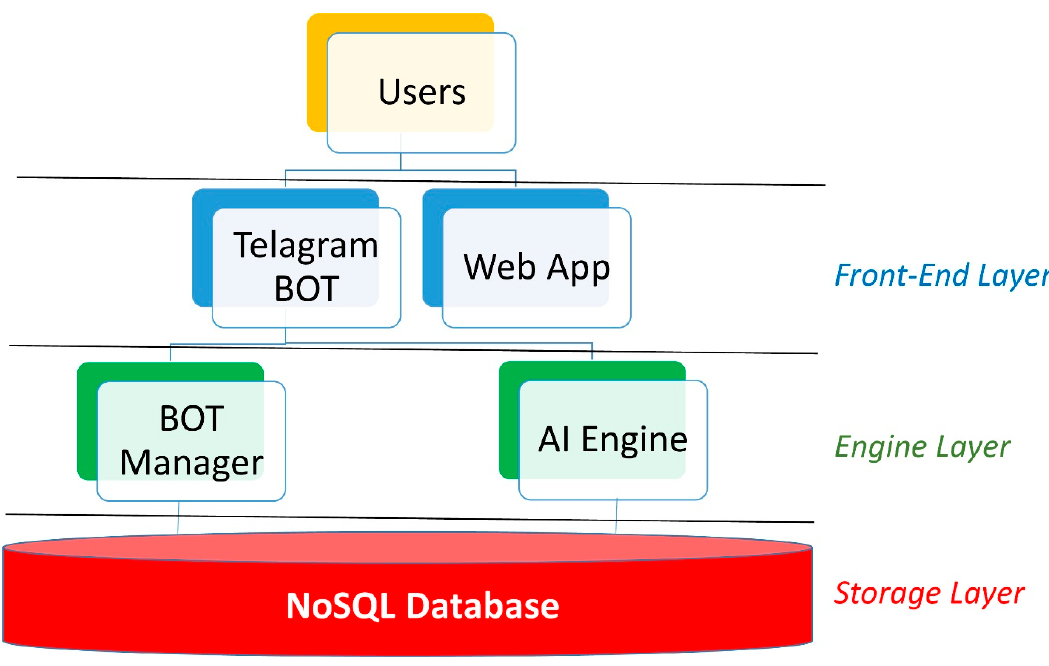
Figure 3. IT architecture overview.